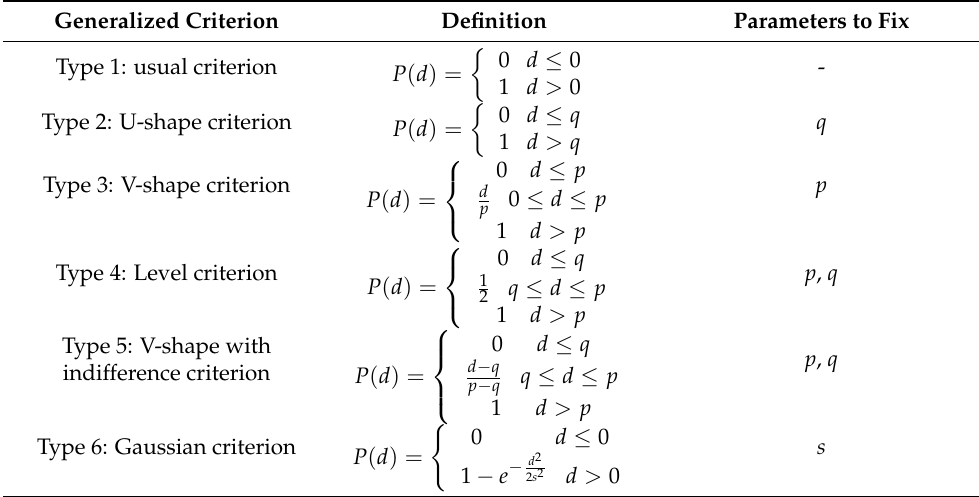
Table 1. Types of preference